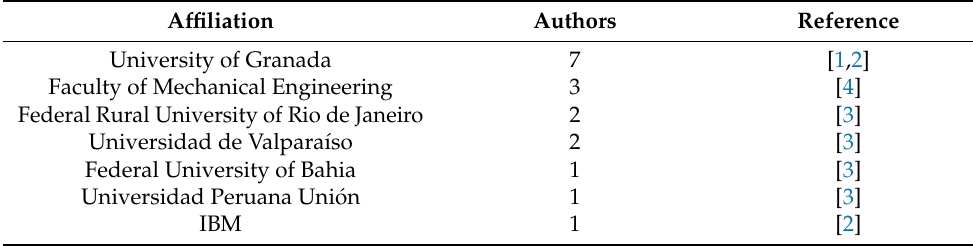
Table 2. Author affiliations.